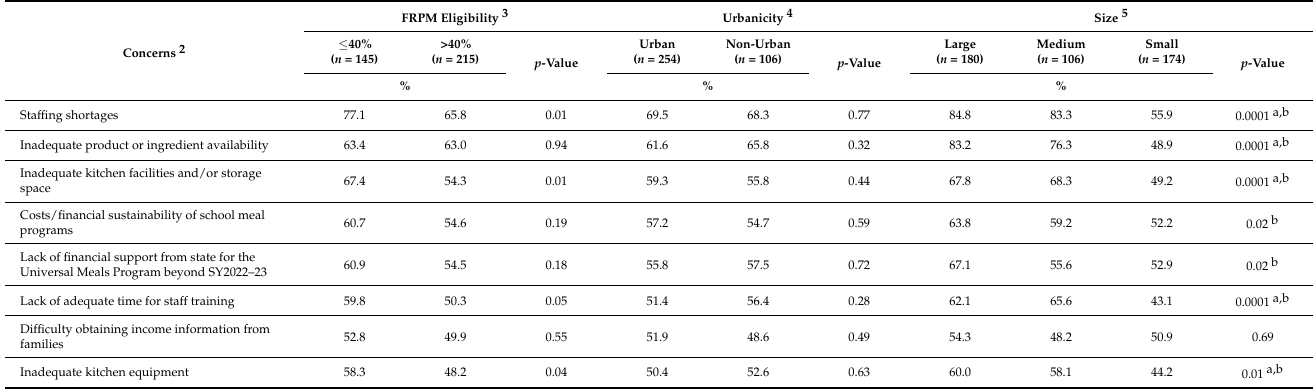
Table 6. Greatest concerns about implementing California’s universal school meals in SY2022–23 by select characteristics of school food authorities ( n = 581) 1 .